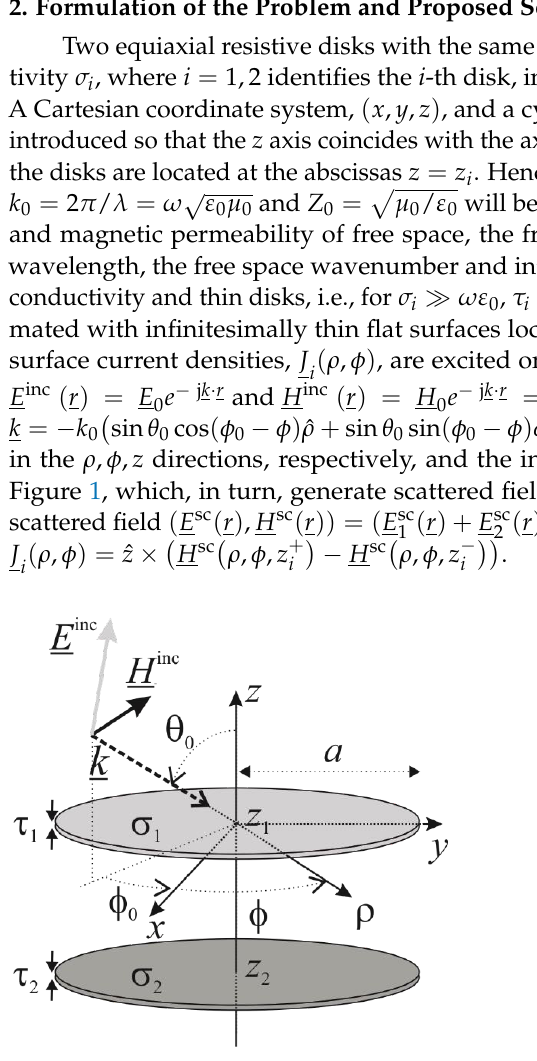
Figure 1. Geometry of the problem.